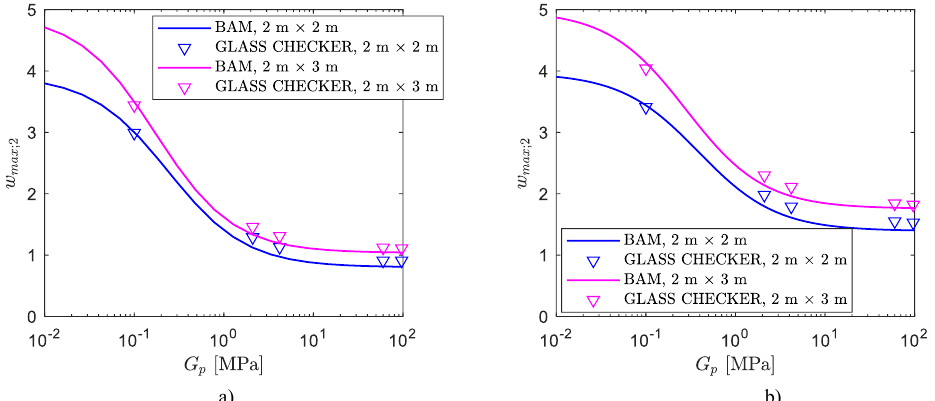
Fig. 15 is the analogue of Fig. 14, for the case of DGUs under concentrated load.